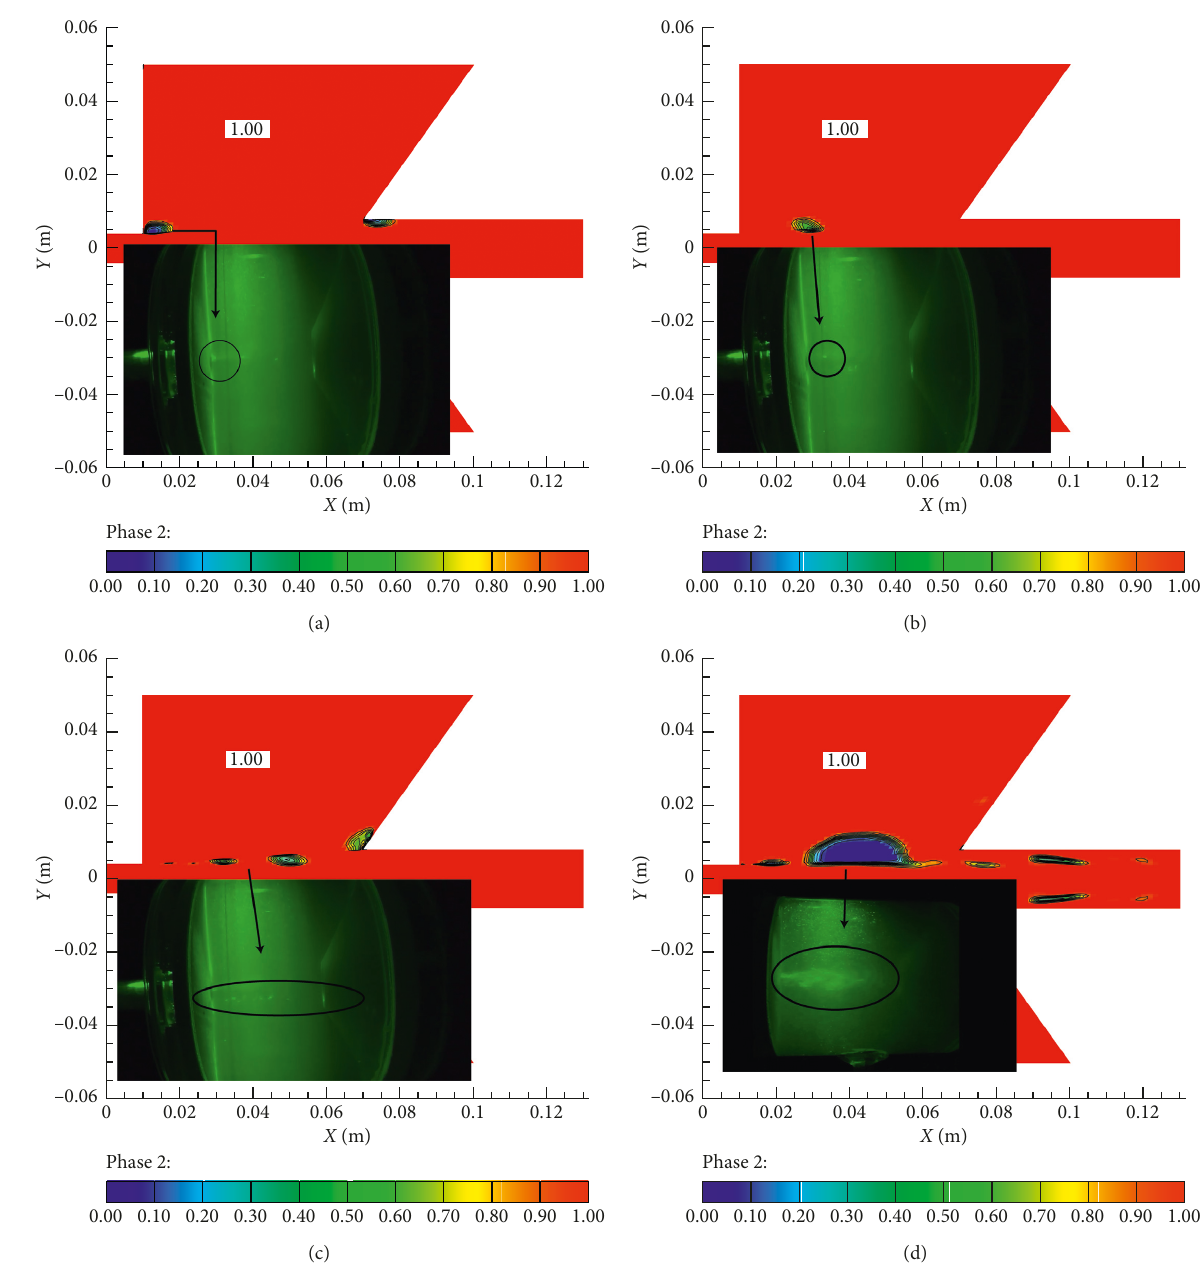
Figure 11: Cavitation status at different cavitation numbers. (a) δ � 1.125. (b) δ � 1.094. (c) δ � 0.826. (d) δ �